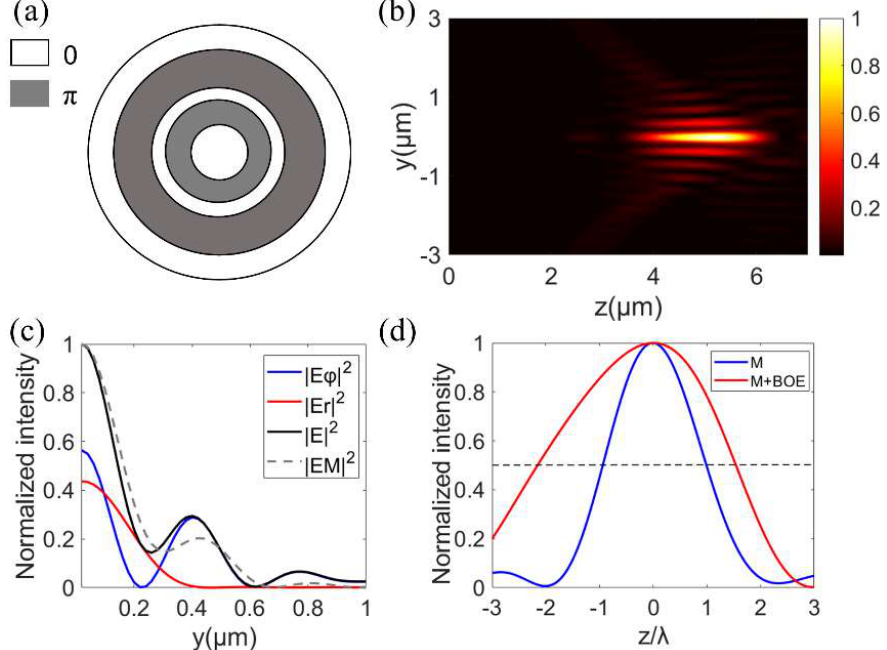
Figure 5. ( a ) Phase distributions of a five − belt BOE in the x–y plane. Phases in the white and gray areas were 0 and π , respectively. ( b ) The intensity distributions of the needle beam generated at the propagating y − z plane. ( c ) A radial normalized intensity distribution in the focal plane. |E M | 2 represents the normalized intensity of the total focal field of the beam focused only by the metalens. ( d ) Represents the normalized intensity profiles along the z − axis. M and M + BOE represent the metalenses without and with the BOE phase focused beam, respectively.